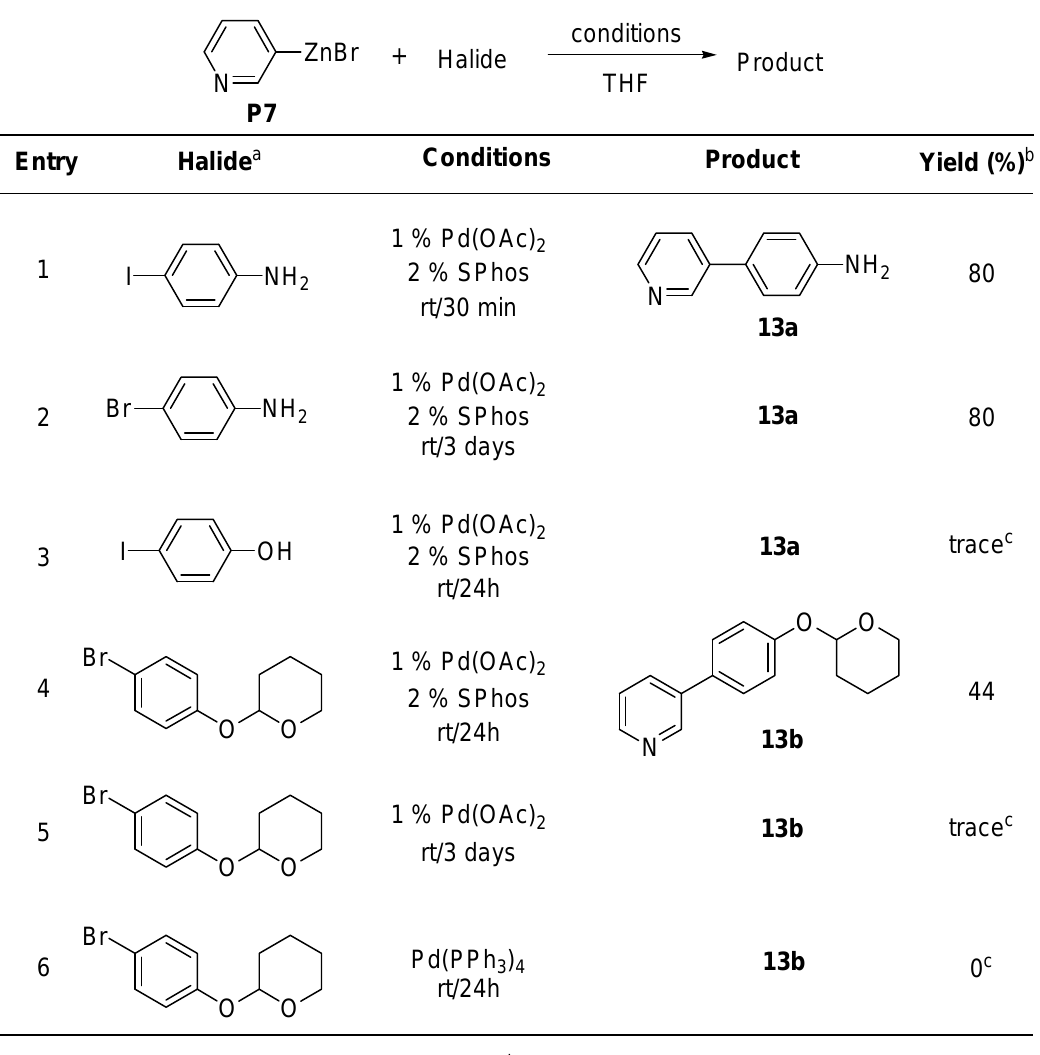
Table 13. Preliminary test for the coupling